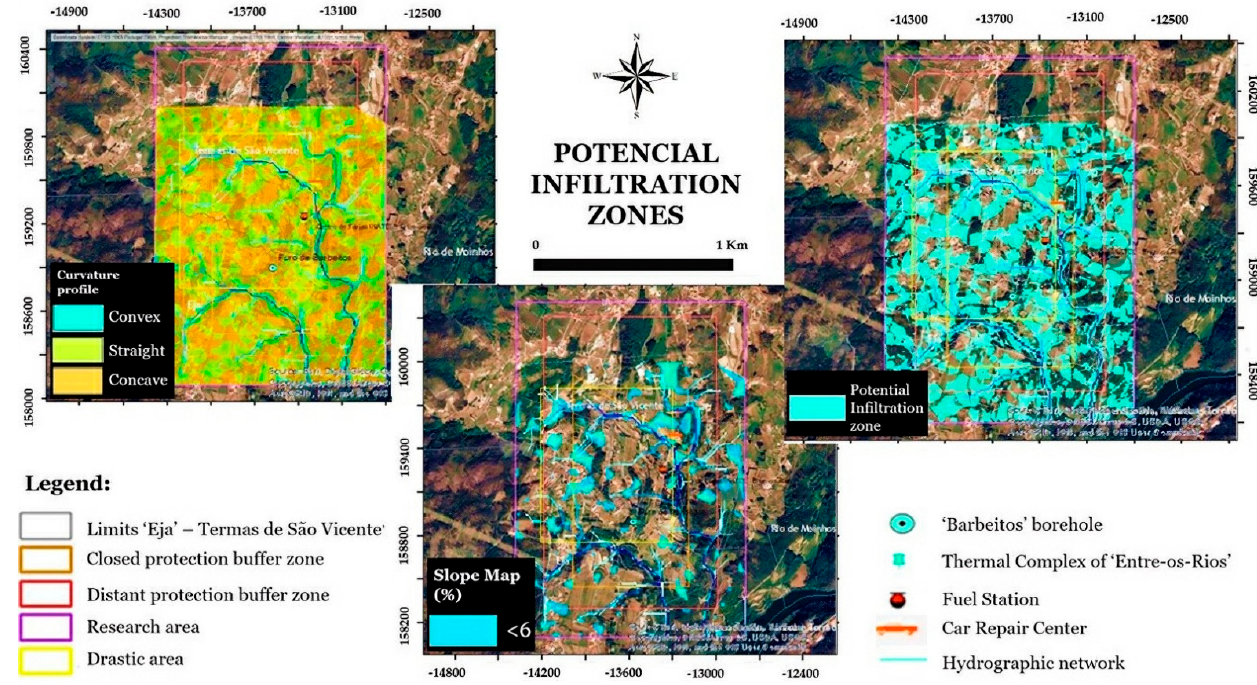
Figure 10. Curvature profile map and infiltration potential areas map of the area surrounding the ‘Barbeitos’ borehole.